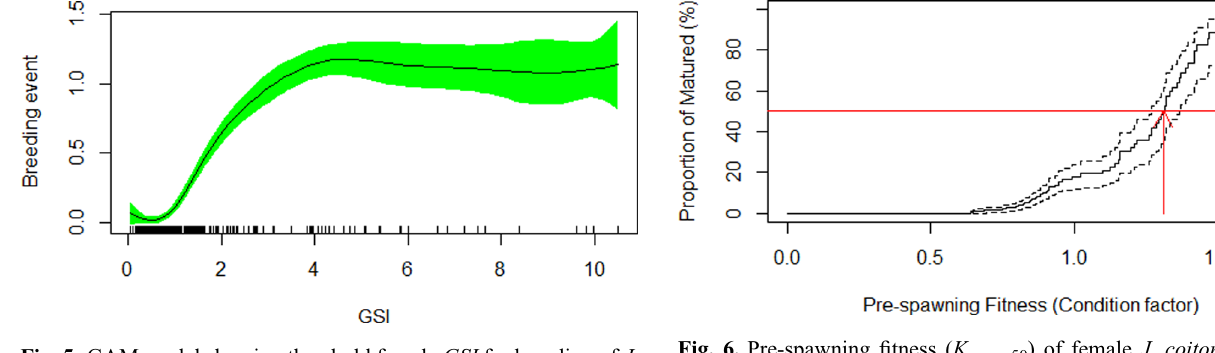
Fig. 5. GAM model showing threshold female GSI for breeding of J. coitor.